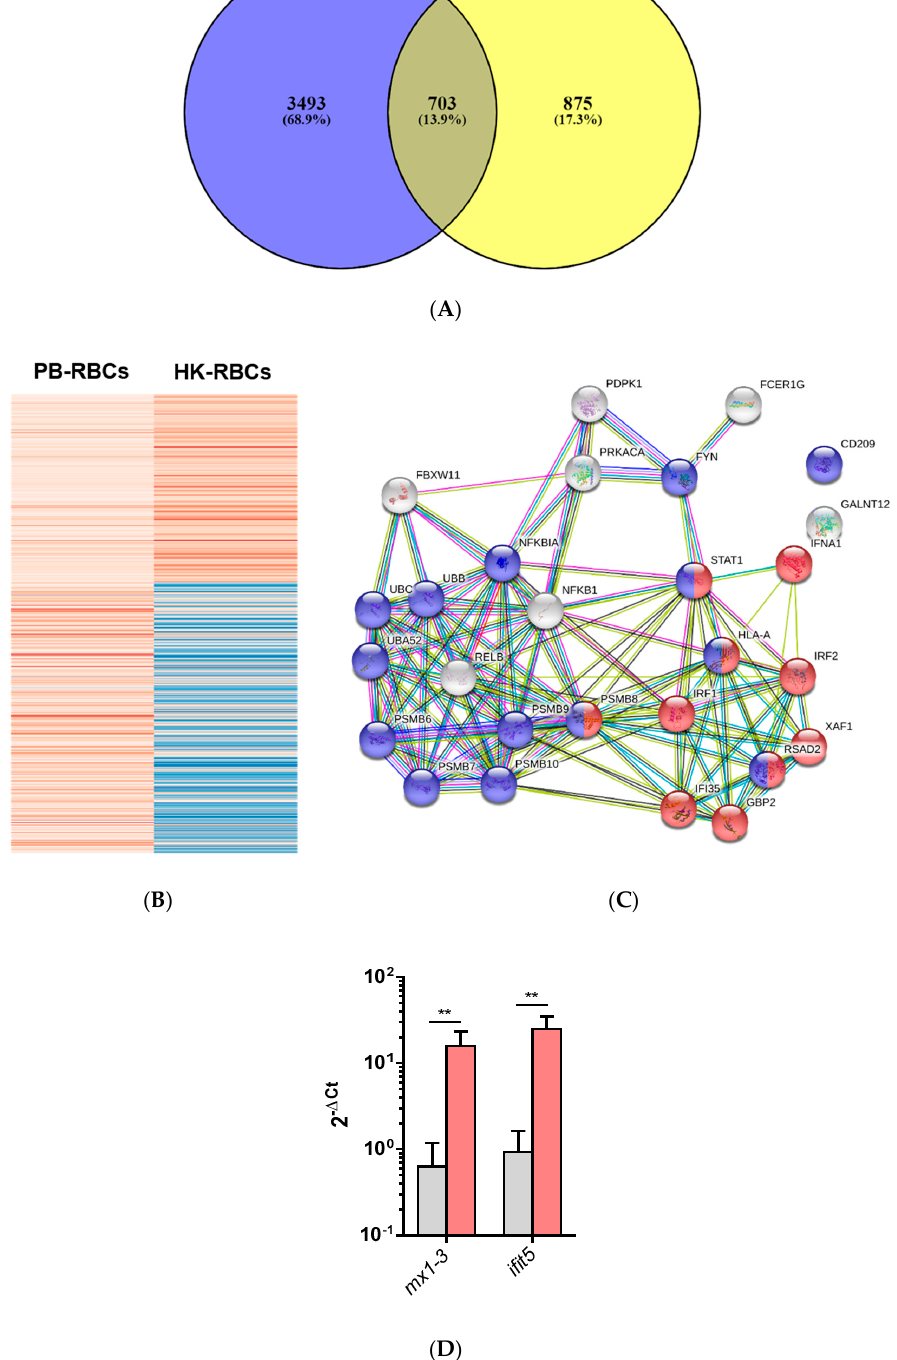
Figure 3. Comparative overview of DEGs shared by HK-PBCs and PB-RBCs. ( A ) Venn diagram of DEGs in RBCs from each tissue. The middle region shows genes expressed in RBCs from both